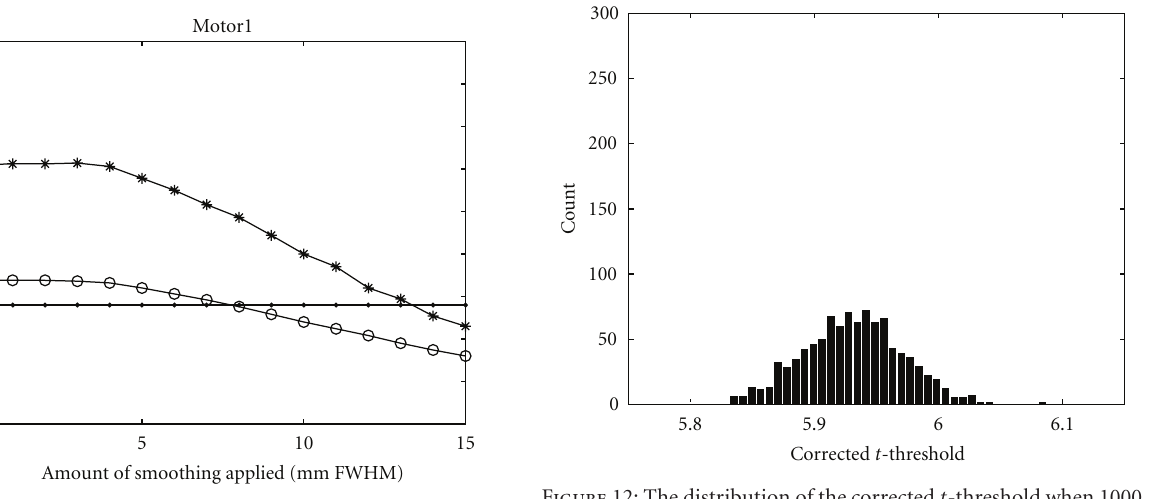
Figure 12: The distribution of the corrected t -threshold when 1000 permutations were